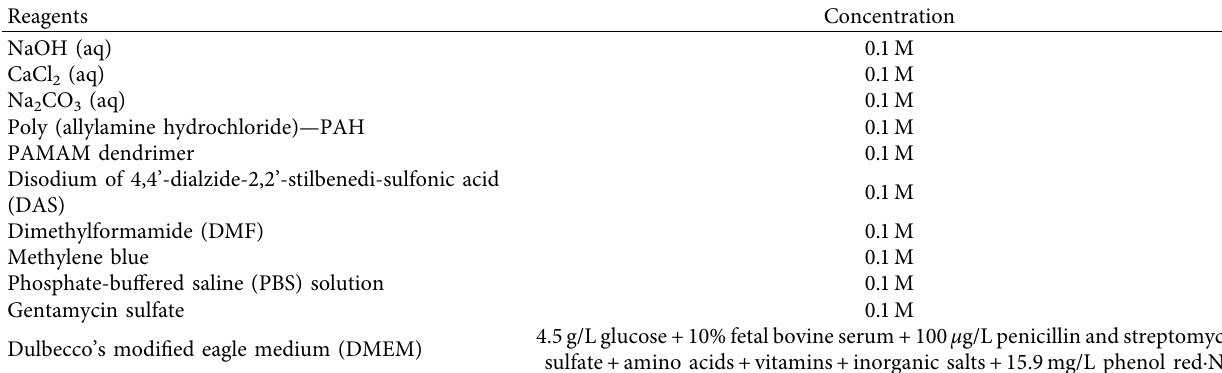
Table 1: Composition of reagents